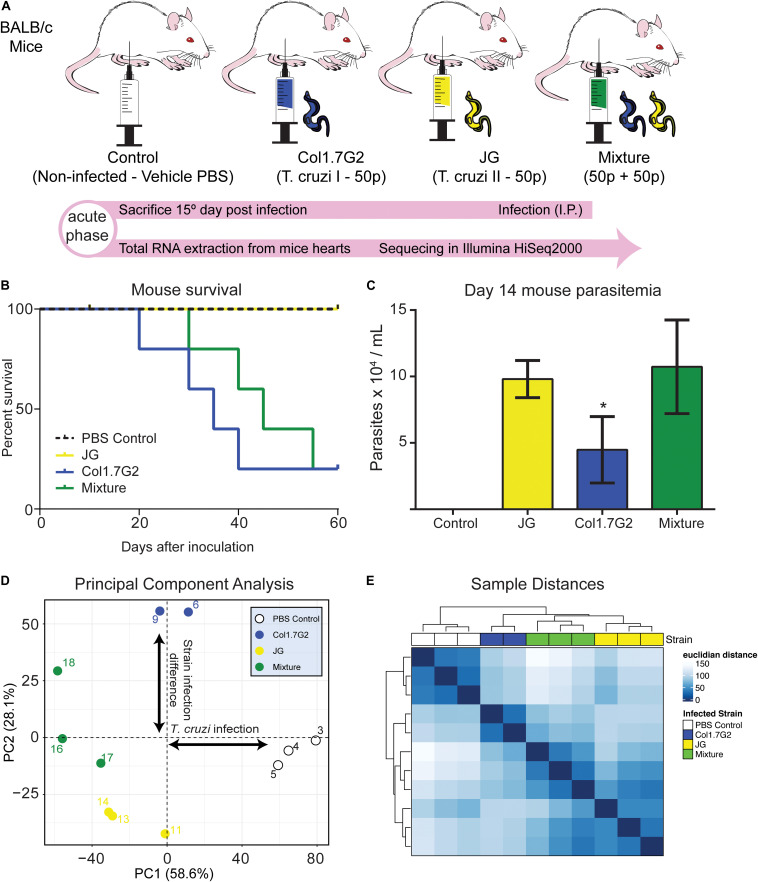
Differential gene expression profile of mouse hearts infected by two T. cruzi strains. (A) BALB/c mice were divided into one non-infected control and three experimental groups, infected with Col1.7G2, JG, or a mixture of the strains with equivalent quantities of both strains. After 15 days, during the acute phase, the mice were euthanized, and the hearts were removed for total RNA extraction and sequencing with an Illumina HiSeq2000. (B) Survival curve of mice infected by Col1.7G2, JG and its mixture 60 days. (C) Mouse parasitemia 14 days after infection. Data represent the mean ± SEM, n = 5 mice/group. *p < 0.05 when comparing the Col1.7G2 group to the JG and mixture groups based on the Kruskal-Wallis test followed by a post hoc Dunn test. (D) To determine the overall expression profile in each mouse sample, the controls (blank circles), Col1.7G2-infected mice (blue circles), JG-infected mice (yellow circles) and mixture-infected mice (green circles) were analyzed by performing principal component analysis (PCA). The first two principal components (PC1 and PC2) are plotted according to the rlog-transformed data of the read counts for each gene. (E) Hierarchical clustering of the rlog-transformed data matrix is shown as a heatmap with the Euclidian distances between the samples.